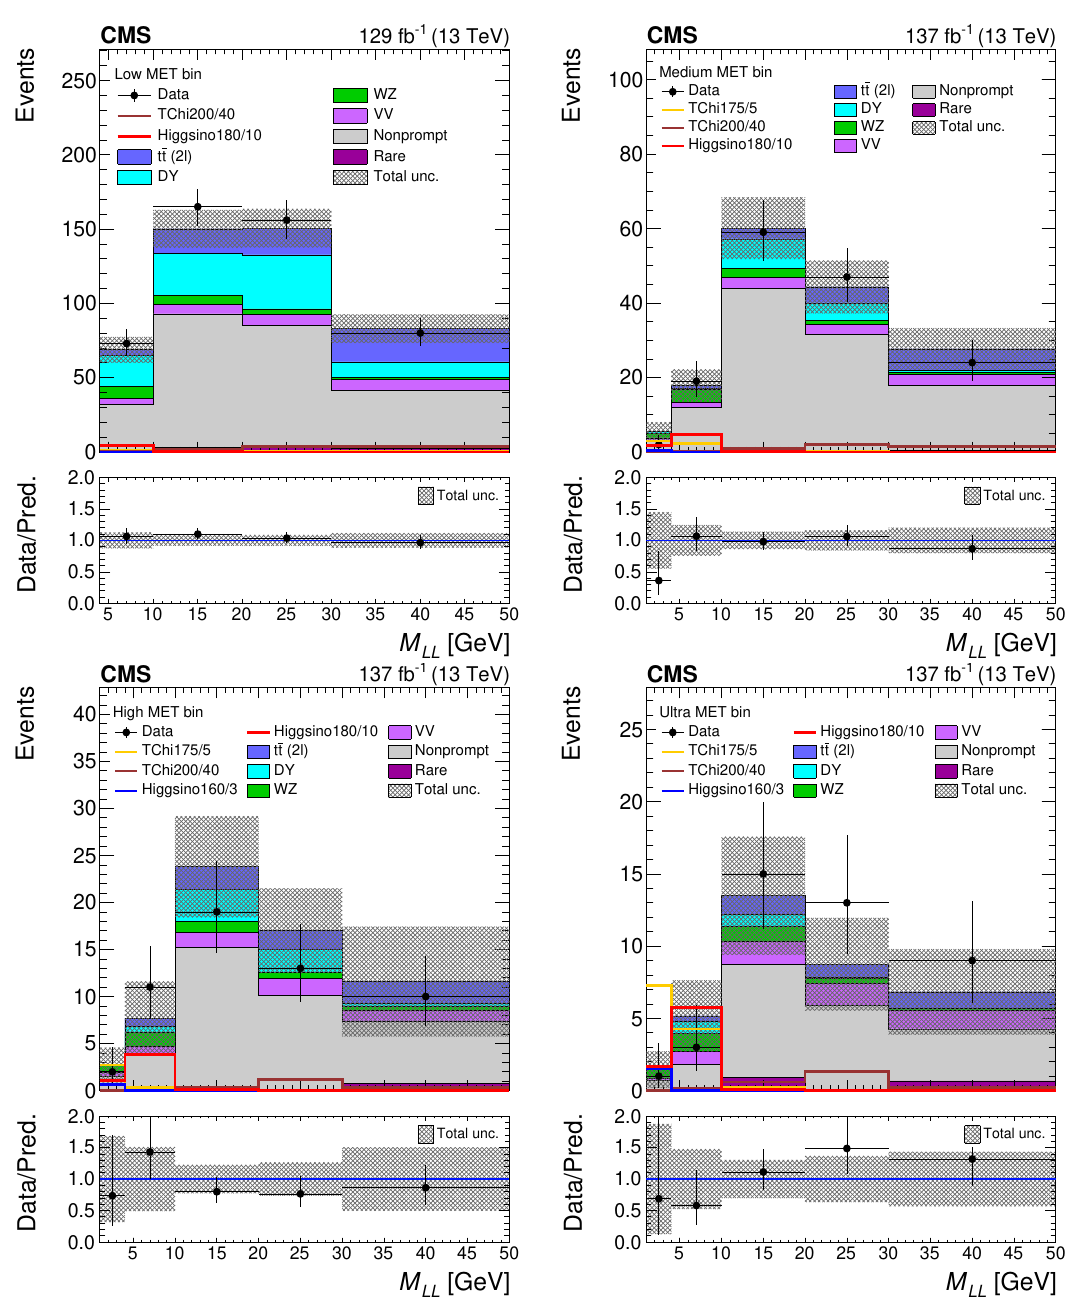
Figure 5 . The 2 ‘ -Ewk SR: the post-fit distribution of the M ( ‘‘ ) variable is shown for the low- (up- per left), medium- (upper right), high- (lower left) and ultra- (lower right) MET bins. Uncertainties include both the statistical and systematic components. The signal distributions overlaid on the plot are from the TChiWZ and the simplified higgsino models in the scenario where the product of eigenvalues is positive and negative, respectively. The numbers after the model name in the m m 0 0 e e e c e c 1 2 legend indicate the mass of the NLSP and the mass splitting between the NLSP and LSP, in